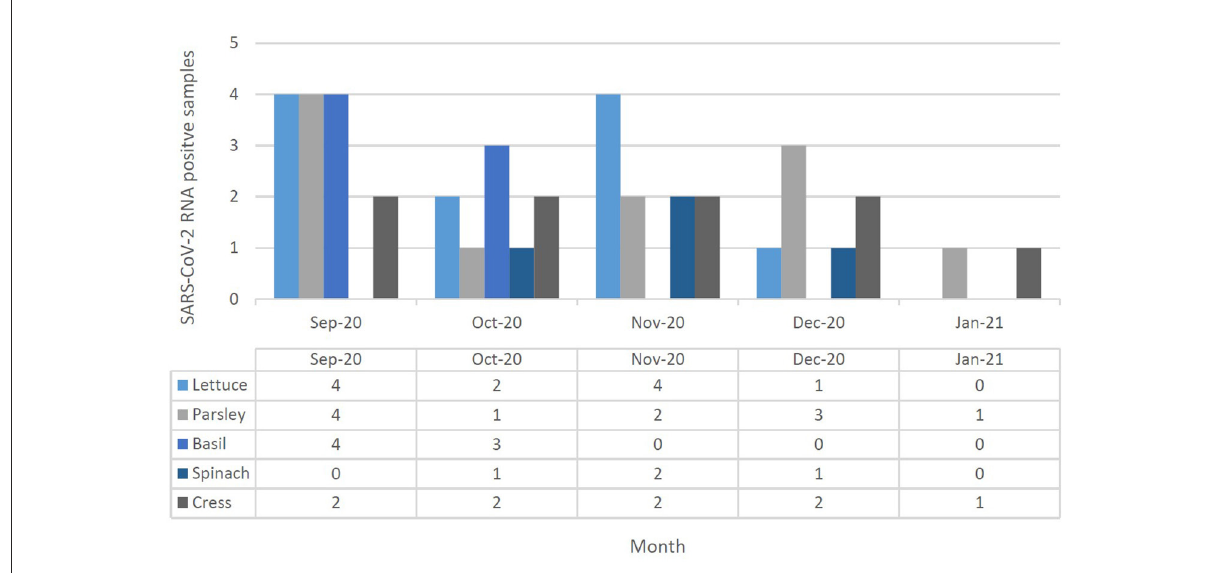
FIGURE4 SARS-CoV-2 RNA presence in leafy green vegetable (lettuce, parsley, basil, spinach, and cress) collected in September 2020 to January 2021 at Tehran, Iran. Different leafy green vegetables were shown in different color in each month,